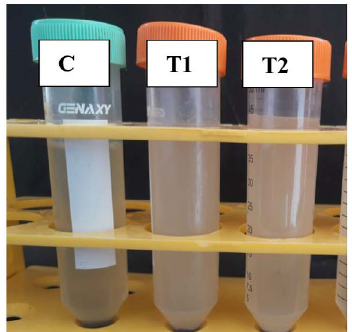
Fig. 4. PU sheet in solid medium with T1. Fig. 3. The PU sheets are immersed in liquid media